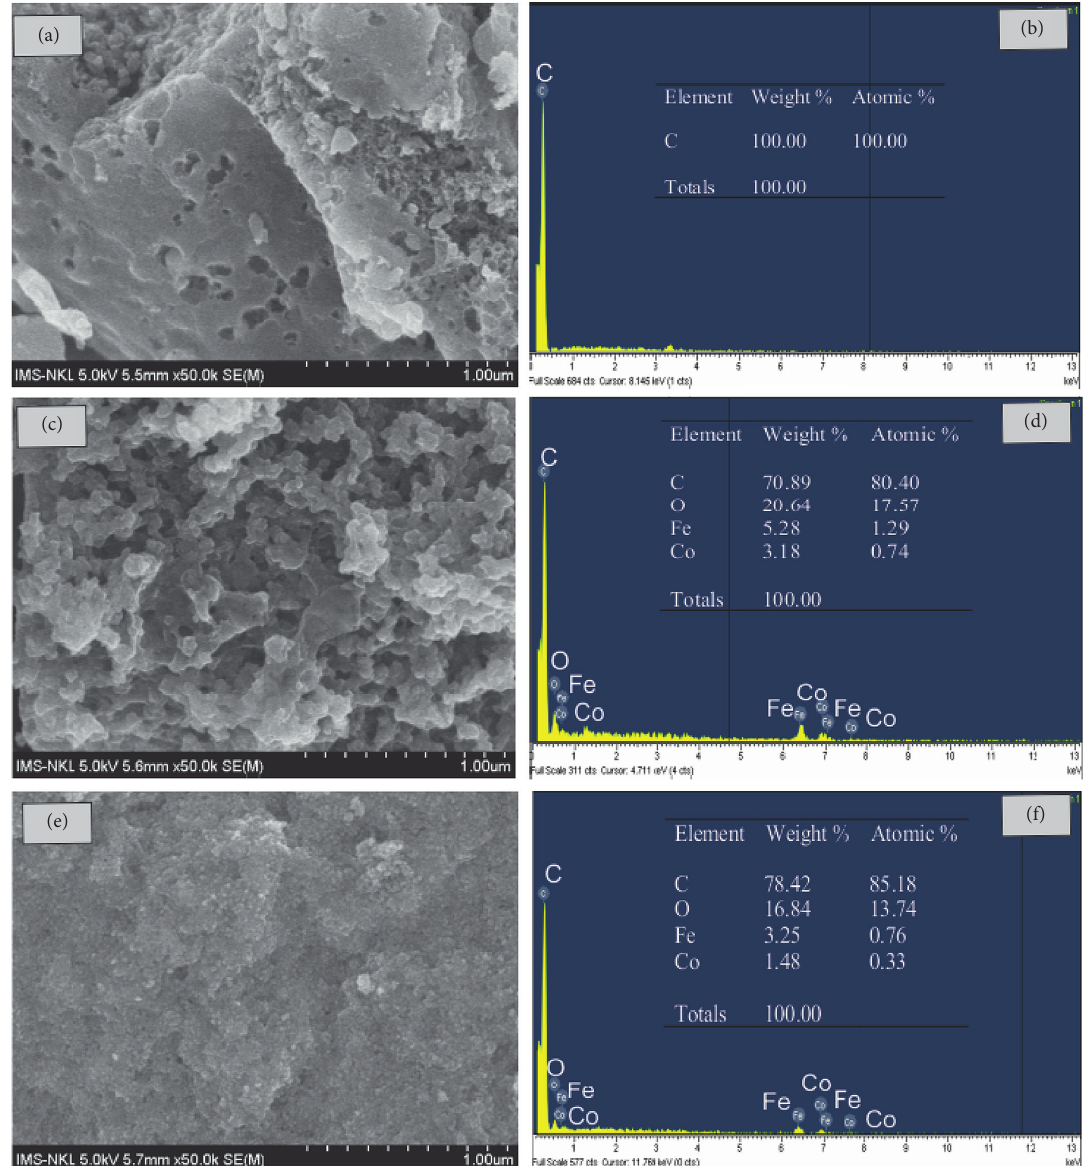
Figure 2: SEM image and EDS spectra of (a, b) coconut activated carbon (CAC), (c, d) CAC/CoFe adsorption Rhodamine B (CAC/CoFe 2 O 4